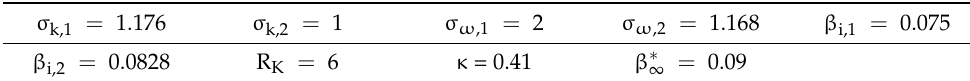
Table 2. Constants of SST K- ω turbulence model